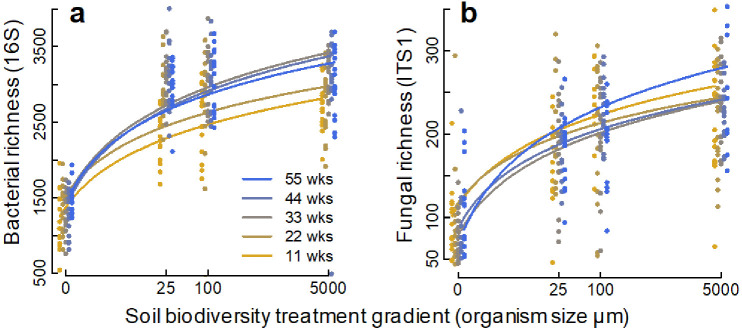
Changes in soil microbial diversity for each treatment along the diversity gradient.Different colours indicate the different time point measurements in weeks (wks). (a) Bacterial richness, (b) fungal richness. Both bacterial and fungal richness declined along the soil biodiversity treatment gradient. Bacterial richness varied among sampling time points, where after 11 and 22 weeks, the richness was lower than at later sampling time points (a). However, the temporal change in bacterial richness was independent of soil biodiversity treatment gradient. Fungal richness did not vary through time and its relationship with the soil biodiversity treatment gradient did not change over time (time by biodiversity treatment gradient interaction). ANOVA model results are shown in Supplementary file 1 -Table 2.